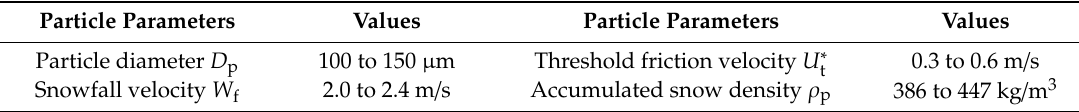
Table 2. Parameters relating to the physical properties of artificial snow.